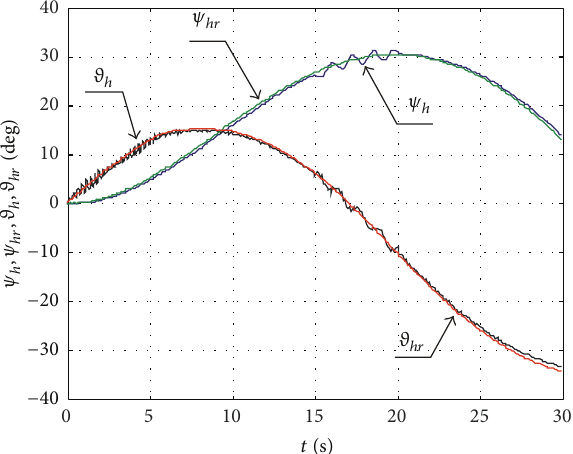
Figure 11: Time-dependent real 𝜗 ℎ , 𝜓 ℎ and desired 𝜗 ℎ𝑟 , 𝜓 ℎ𝑟 angles specifying the location of the head axis for optimum controls without the influence of disturbances.